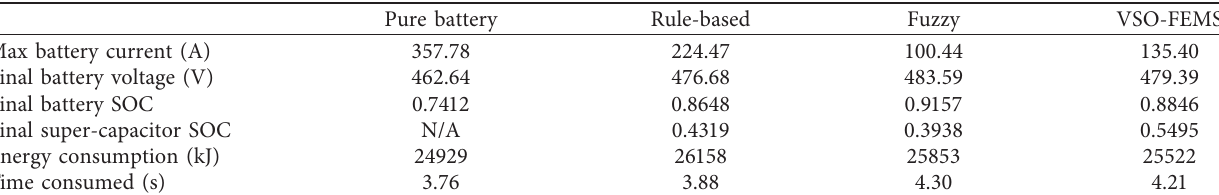
Figure 9: (a) Power allocation of HESS. (b) Comparison currents of battery and super-capacitor. Table 8: Results